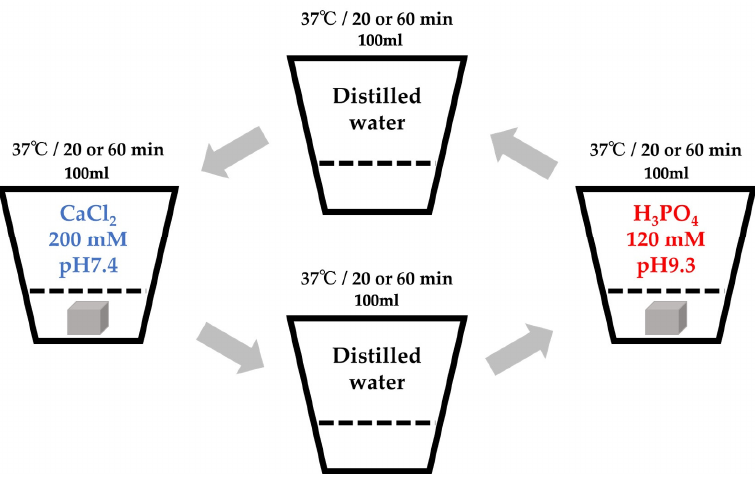
Figure 1. Schematic of the alternate immersion method.